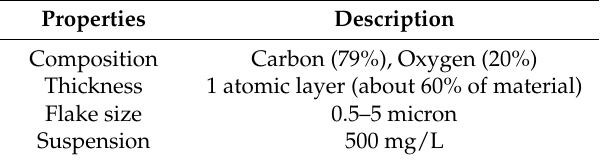
Table 4. Specification of graphene oxide (GO) (data provided by GO producer).